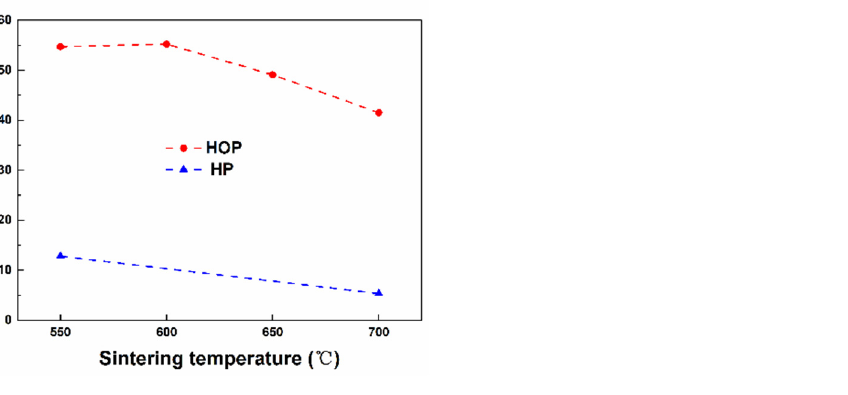
Figure 8. Fraction of deformation area as a function of sintering temperature for samples sintered by HOP and HP.